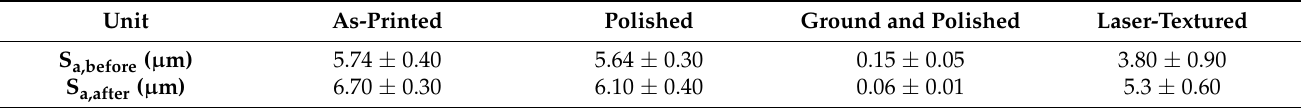
Table 2. Average area surface roughness S a of additively manufactured H13 steel samples in surface conditions as-printed, polished, ground and polished, and laser-surface-textured before and after tribological testing. Surface roughness was determined by white-light interferometry at five different positions on each sample. The given error is the standard deviation of these measurements. Unit As-Printed Polished Ground and Polished